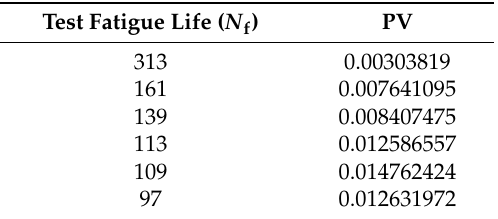
Table 6. Results of N f and PV.